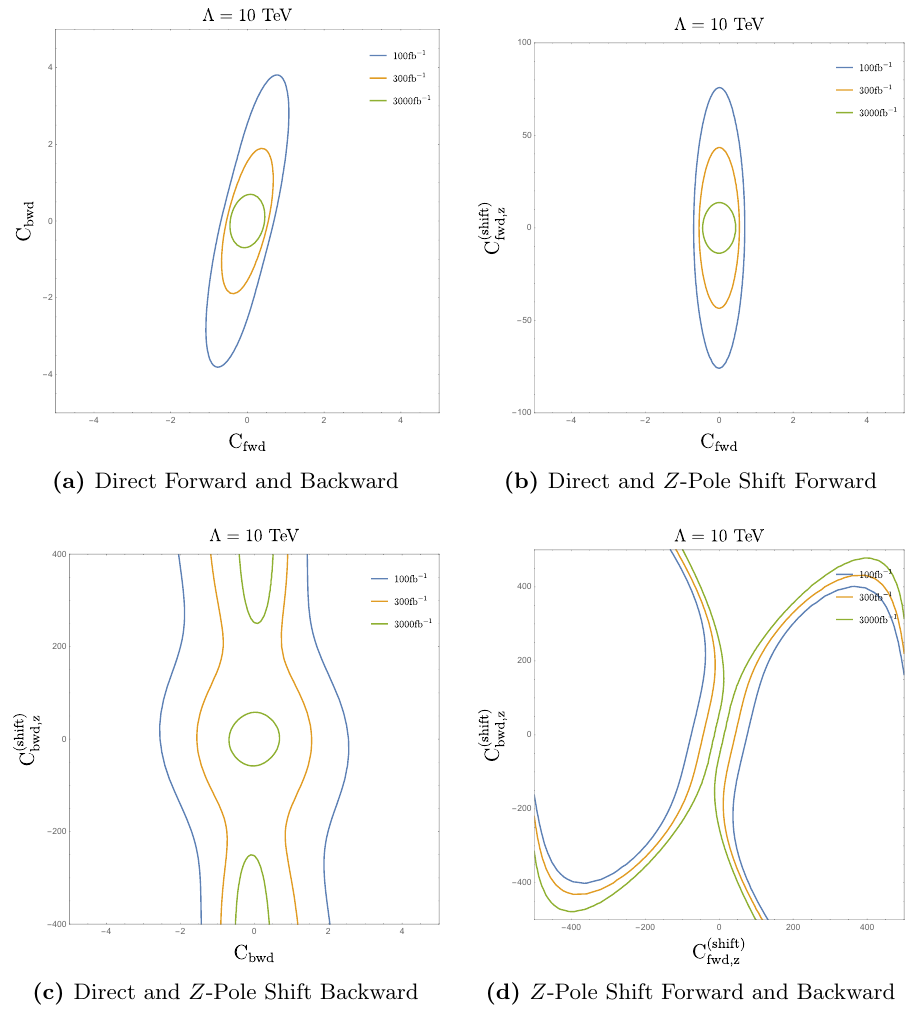
Figure 2. Constraints on SMEFT parameter space arising from this analysis. All plots show slices along the plane of vanishing Wilson coe(cid:14)cients not shown. The blue, orange, and green curves correspond to the projected constraints based on performing this analysis using 100, 300, and 3000 fb (cid:0) 1 of